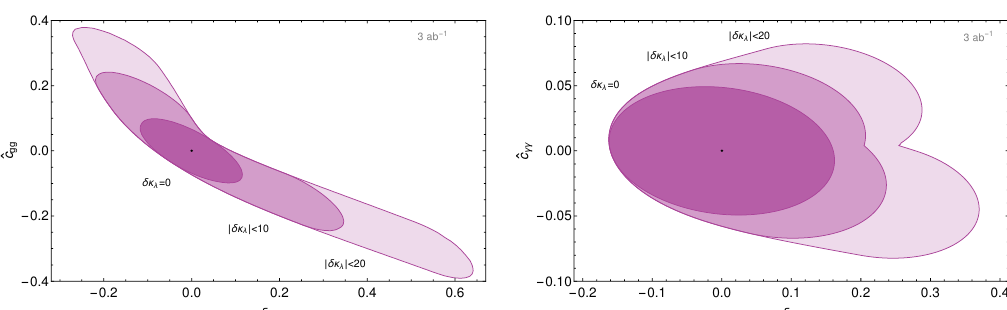
Figure 3 . Constraints in the planes ( (cid:14)y t ; ^ c gg ) (left panel) and ( (cid:14)y b ; ^ c (cid:13)(cid:13) ) (right panel) obtained from a global (cid:12)t on the single-Higgs processes. The darker regions are obtained by (cid:12)xing the Higgs trilinear to the SM value (cid:20) (cid:21) = 1, while the lighter ones are obtained through pro(cid:12)ling by restricting (cid:14)(cid:20) (cid:21) in the ranges j (cid:14)(cid:20) (cid:21) j (cid:20) 10 and j (cid:14)(cid:20) (cid:21) j (cid:20) 20 respectively. The regions correspond to 68% con(cid:12)dence level (de(cid:12)ned in the Gaussian limit corresponding to (cid:1) (cid:31) 2 = 2 :